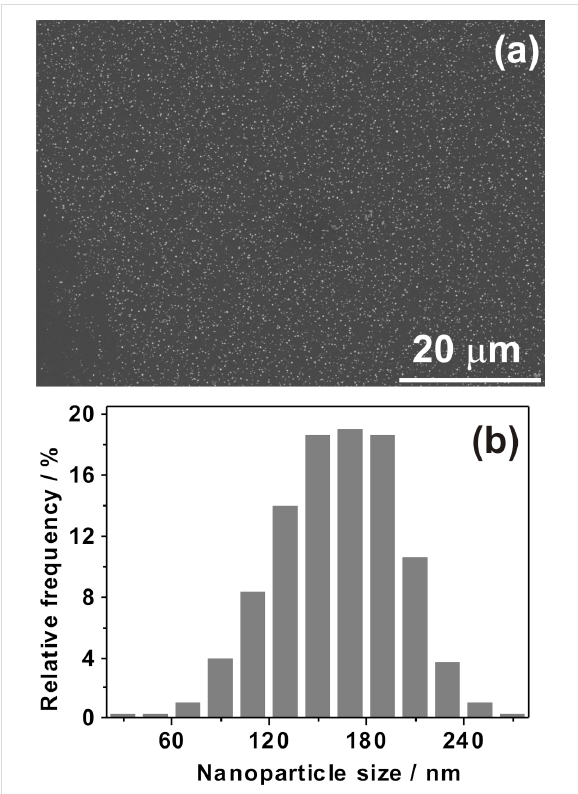
Figure 2: (a) SEM image and (b) particle size distribution of Fe nano- particles electrochemically deposited onto GC.